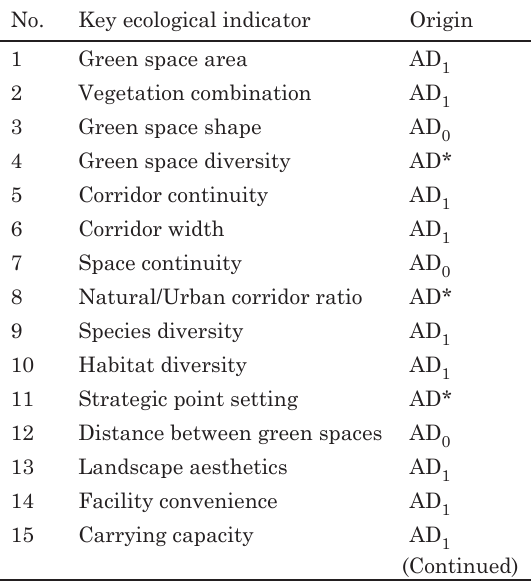
table 4. 23 Key ecological indicators after